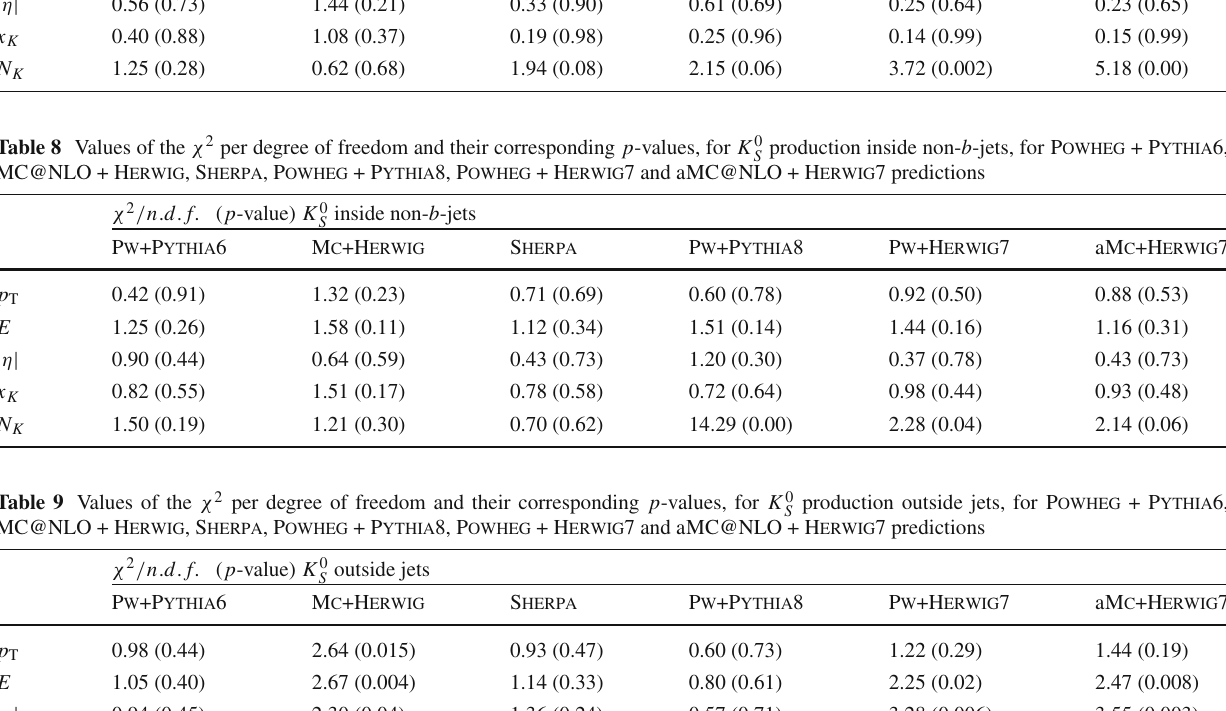
production inside non- b -jets, for Powheg + Pythia6 , S